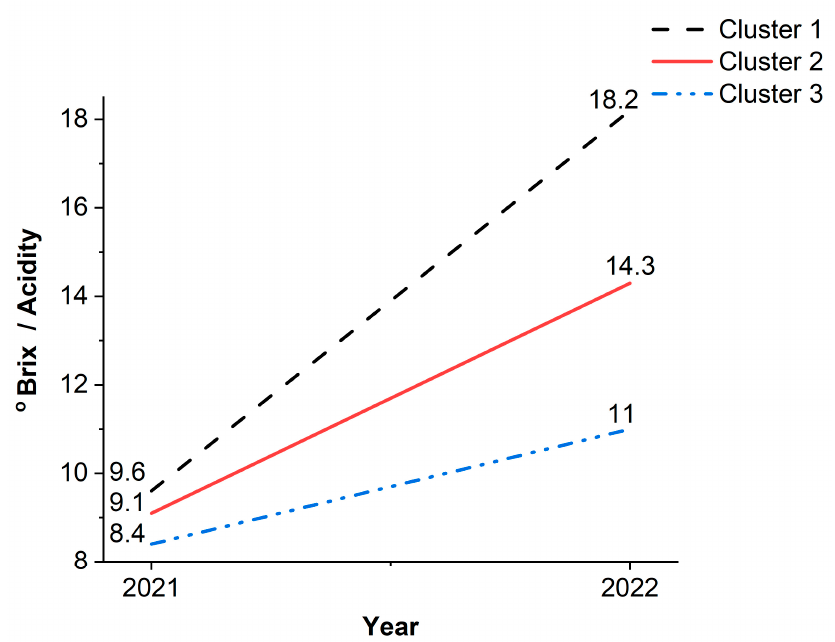
Figure 6. Grouping cultivars of strawberry according to the ratio of ◦ Brix/Acidity by the K-mean cluster analysis.